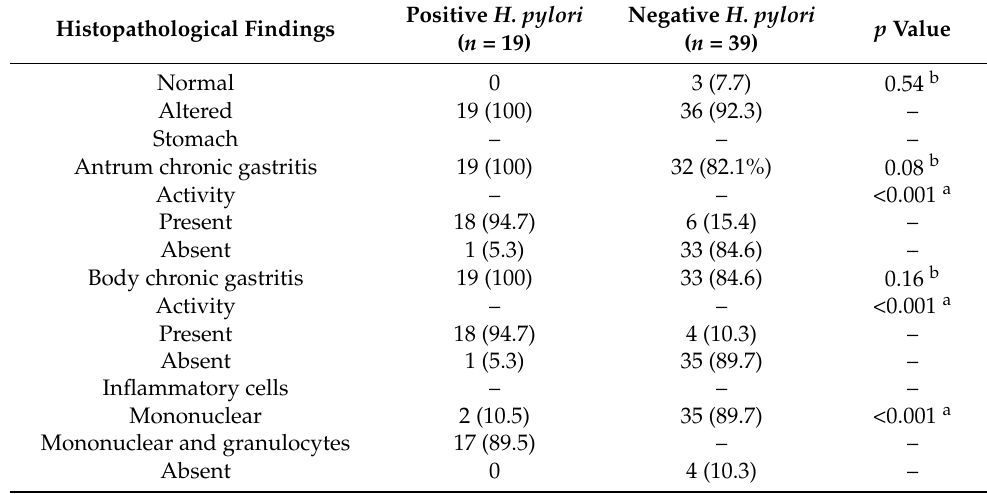
Table 4. Comparison of Histopathological Findings According with the Presence of H.-pylori in Patients with